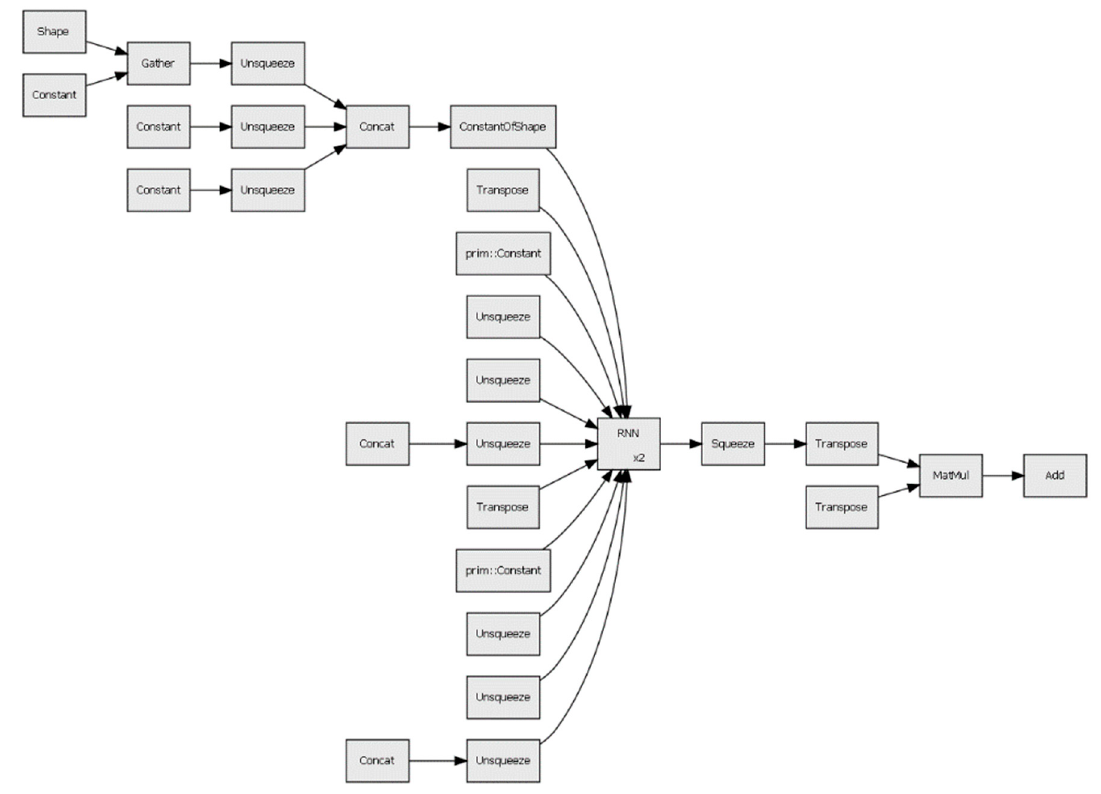
Figure 4. Visualization of encoder-decoder architecture.